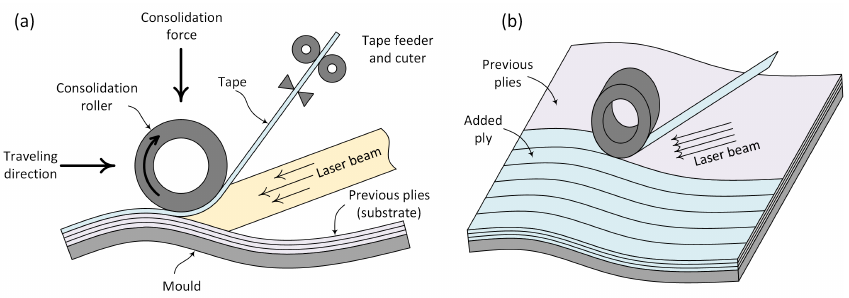
Figure 1. The automated tape placement (ATP) composite manufacturing: ( a ) physical phenomena; ( b )